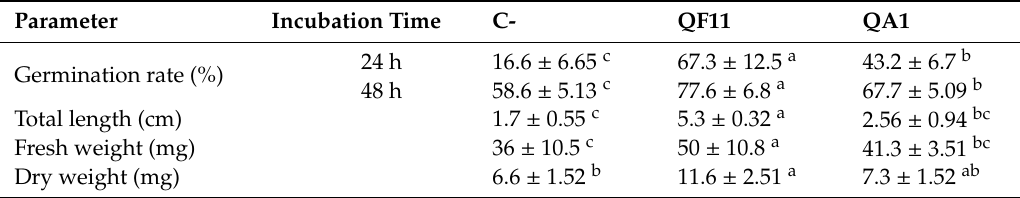
Table 3. E ff ect of strains QA1 and QF11 on quinoa seed germination parameters. Table 3. Effect of strains QA1 and QF11 on quinoa seed germination parameters.